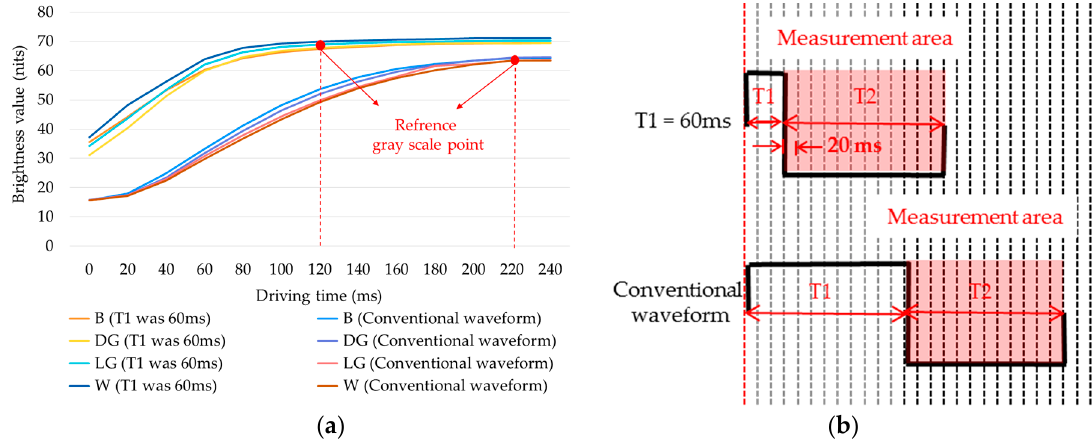
Figure 6. Brightness curves at different initial grayscale. ( a ) The brightness curve of T2. ( b ) The driving waveform used in this measurement.